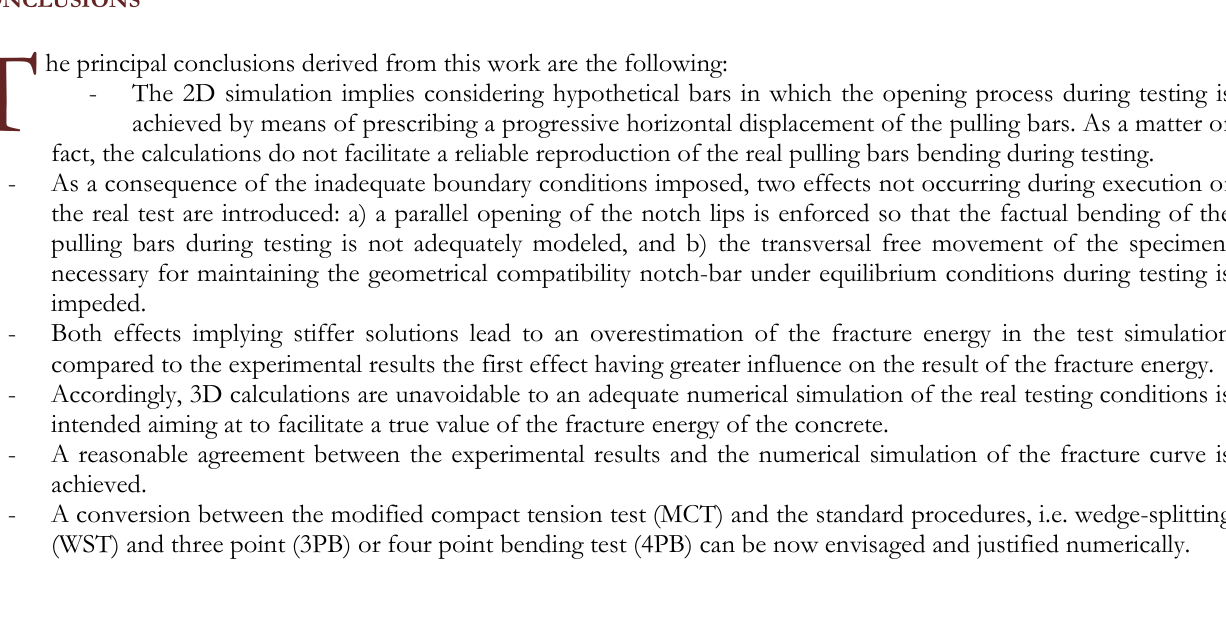
Figure 14: Direct comparison for the experimental and numerical energy curves once corrected. (a) Specimen 1; (b) Specimen 2. C